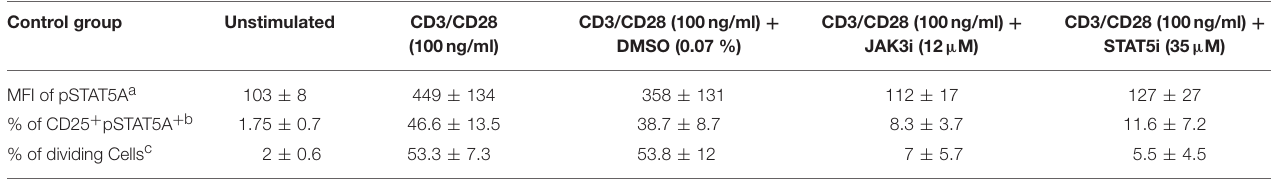
TABLE 1 | Summary of MFI of pSTAT5A, % of CD25 + pSTAT5A + cells and % of dividing cells, before and after treatment with JAK3 and STAT5 inhibitors in CD3/CD28 stimulated cells ( n = 6). Control group